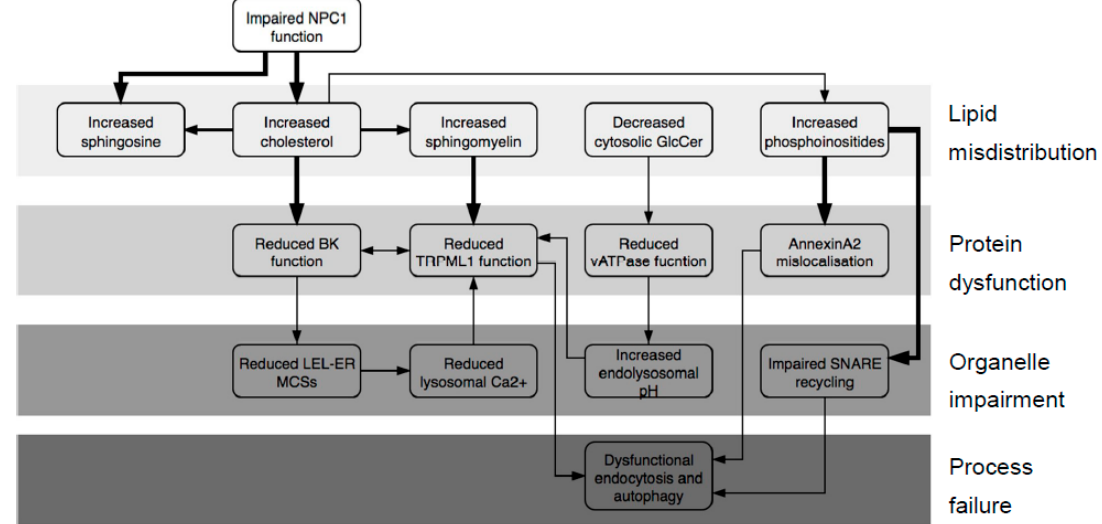
Figure 1. Pathological cascade in Niemann–Pick type C disease (NPCD). All steps are supported by at least one published report referenced in the text; steps shown with bold arrows are the subject of this publication.